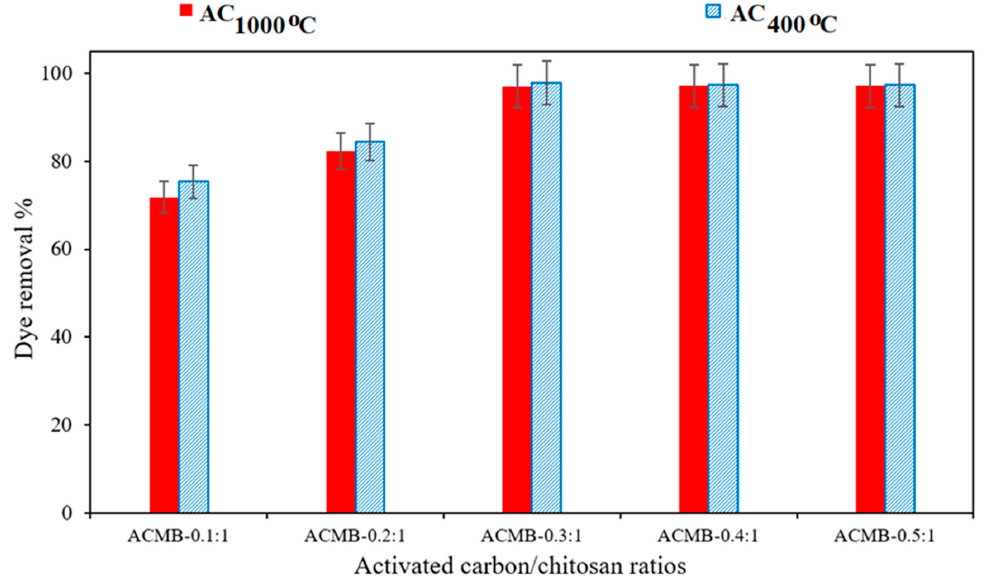
Figure 12. The effect of activated carbon/chitosan ratios on DB78-dye-removal efficiency.